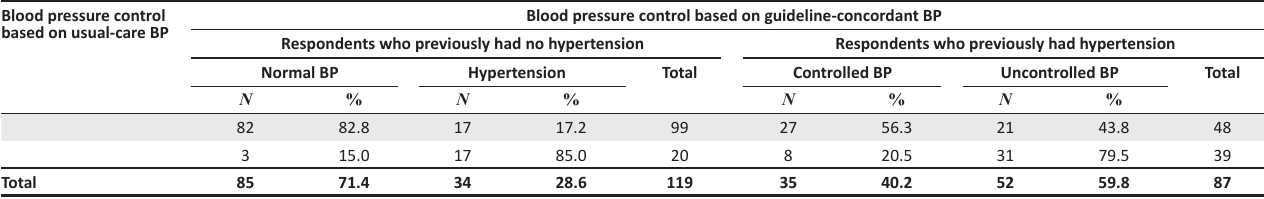
TABLE 3: Pattern of blood pressure among respondents based on usual-care and standard blood pressure measurement protocols. Blood pressure control based on usual-care BP